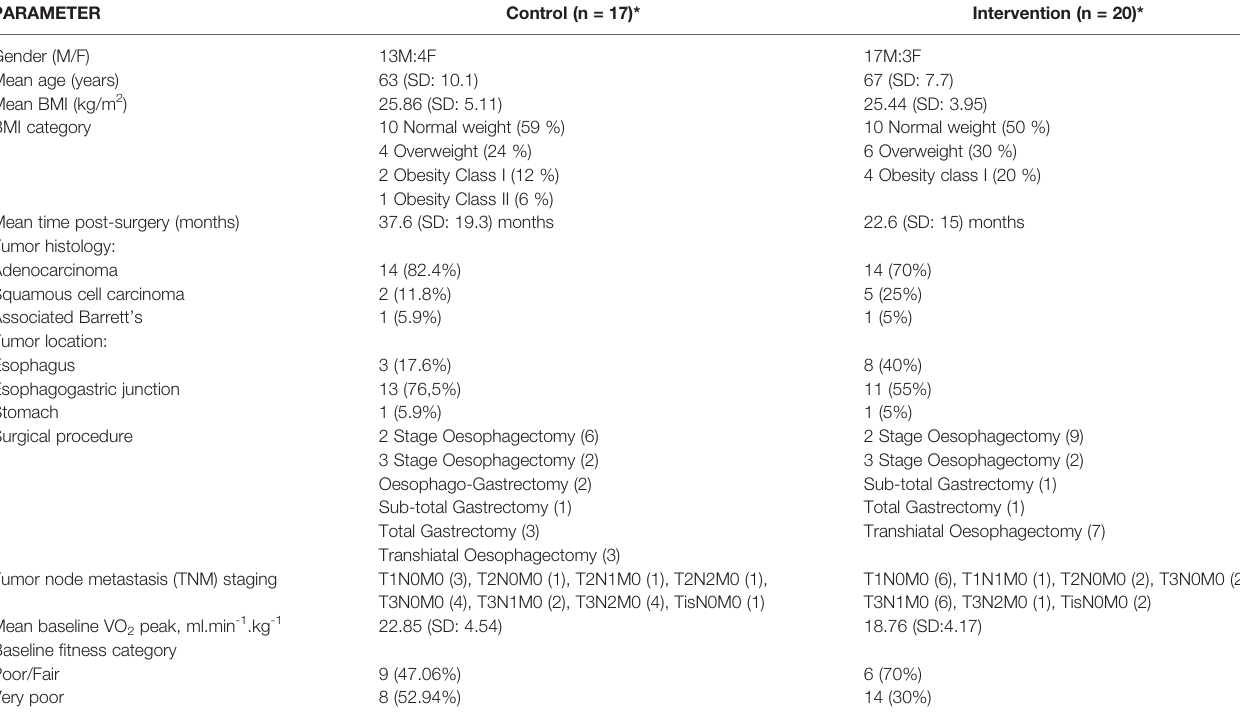
TABLE 1 | Patient Demographics.